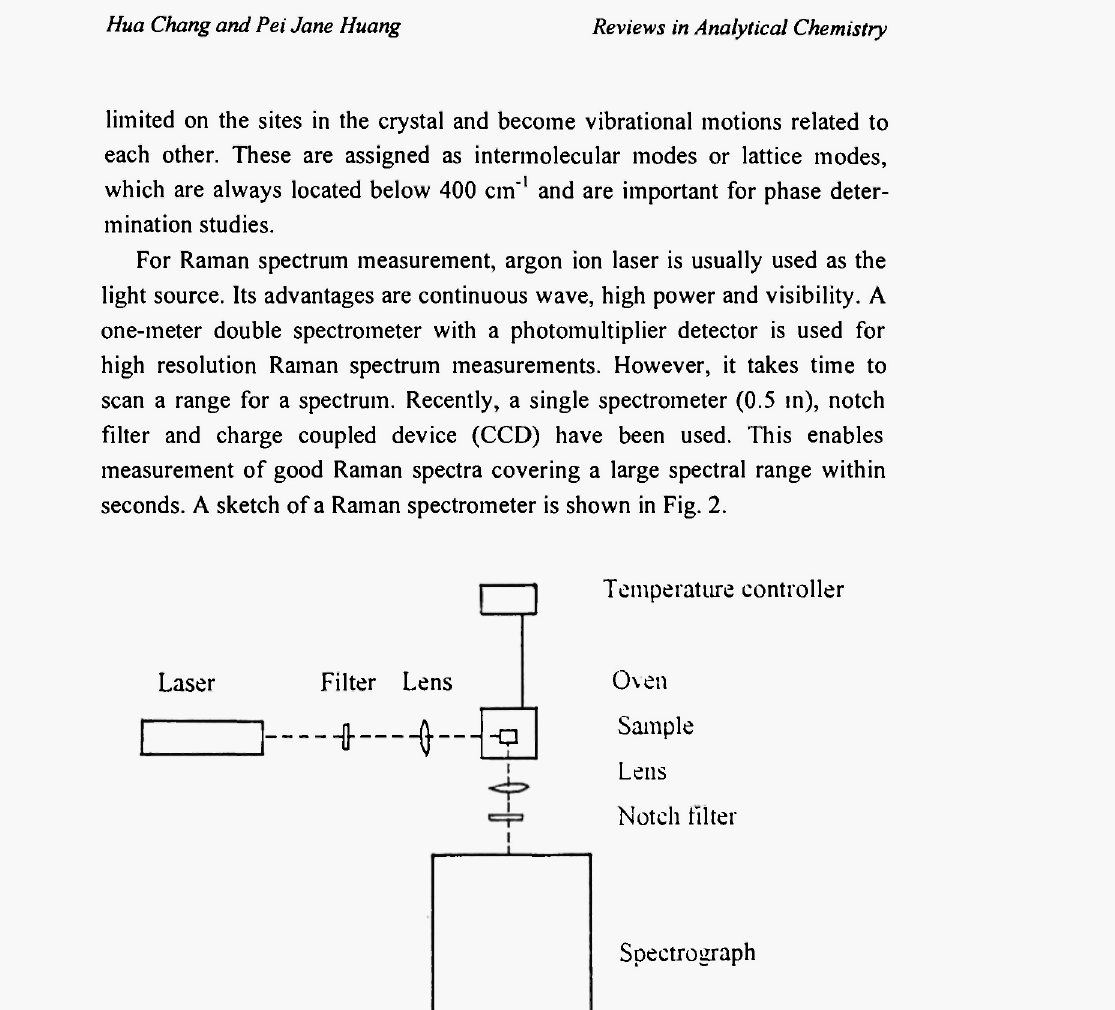
Fig. 2: A typical setup for thermo-Raman spectrometer with a notch filter, a single spectrometer and a CCD